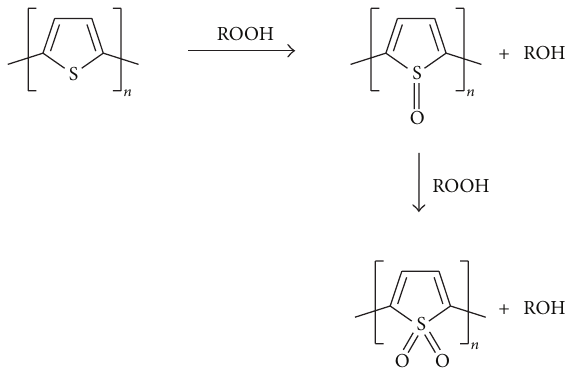
Scheme 3: Mechanism of polythiophene as an antioxidant (hydrop- eroxide decomposition reactions in presence of polythiophene).